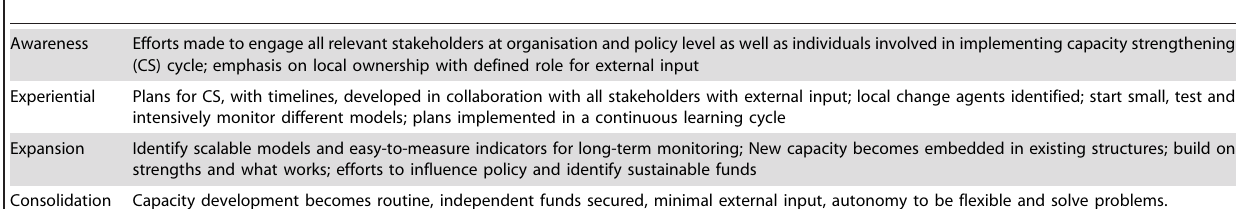
Table 1. Framework for designing and evaluating a health research capacity-building programme.